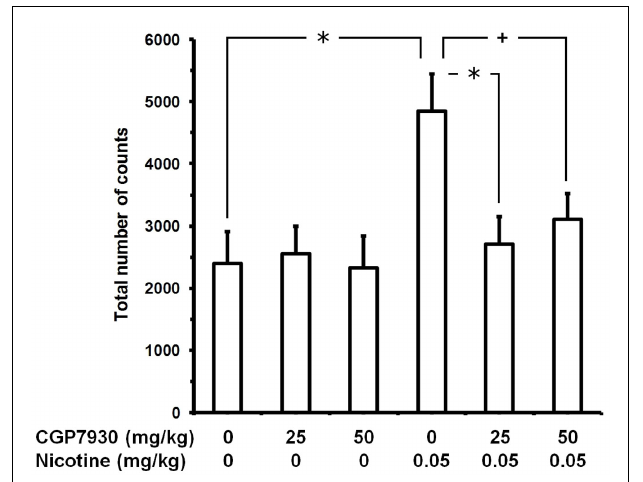
FIGURE 2 | Prevention of nicotine-induced hyperlocomotion by CGP7930 in male CD1 mice. Mice were initially treated with CGP7930 (i.g.); 60min later, mice were treated with nicotine (tartrate salt). Locomotor activity recording started immediately after nicotine administration and lasted for 20 consecutive min. Data are expressed as mean ± SEM of the total number of counts (photocell breaks) recorded automatically by the apparatus in n = 16–18 mice. + , P < 0.05 and *, P < 0.01 (Newman–Keuls test).